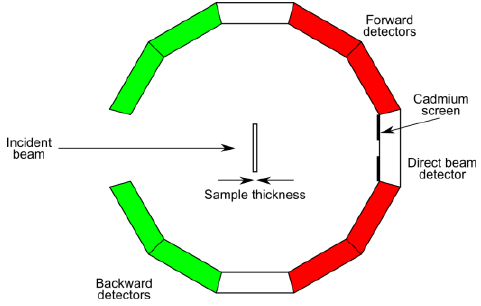
Fig. 5 : Scheme of the modeled experiment. The sample thickness is the main parameter to analyse.